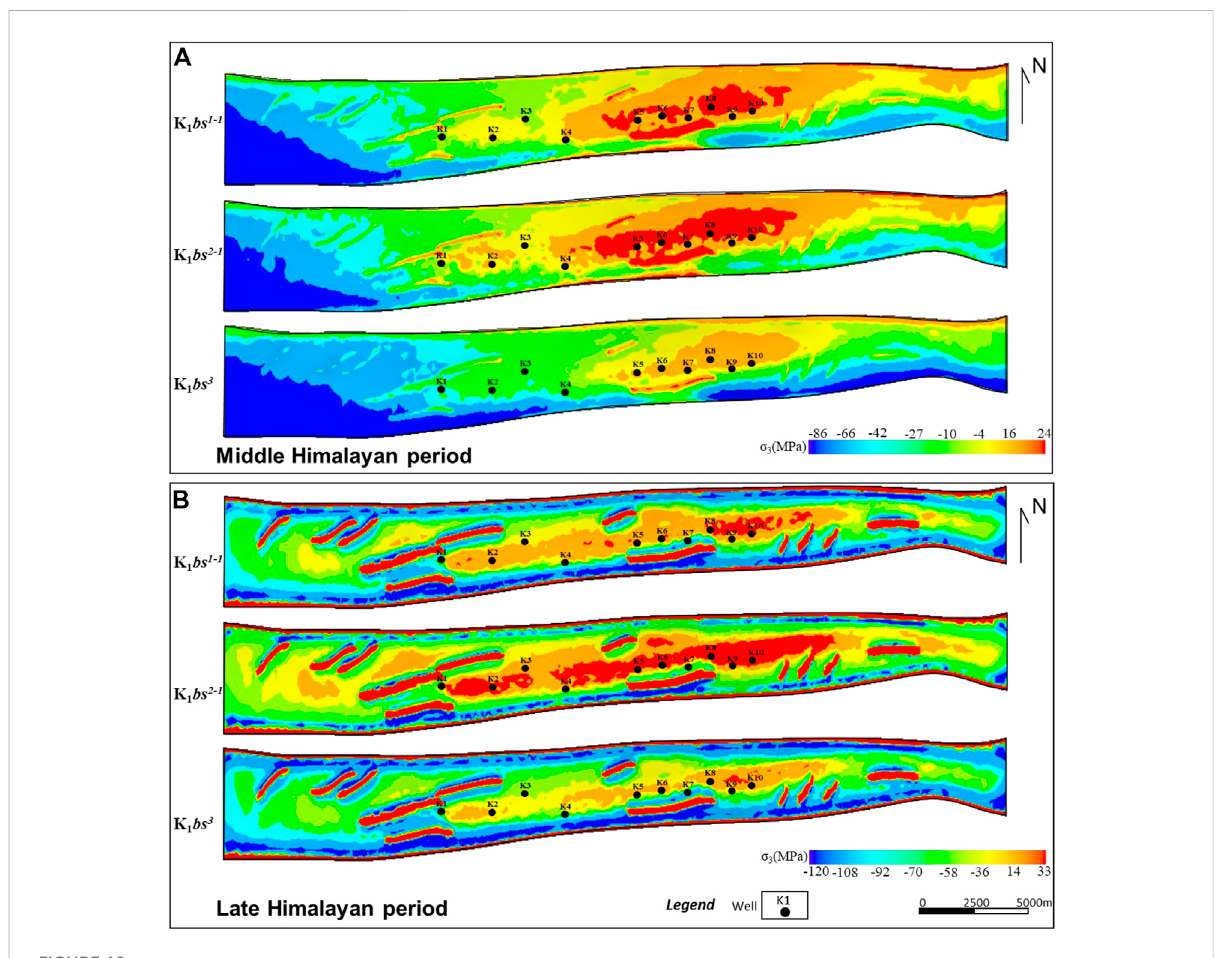
FIGURE 10 Distribution of paleo-tectonic stress fi eld in different period. (A) Minimum principal stress in middle Himalayan period of target layer; (B) Minimum principal stress in late Himalayan period of target layer.